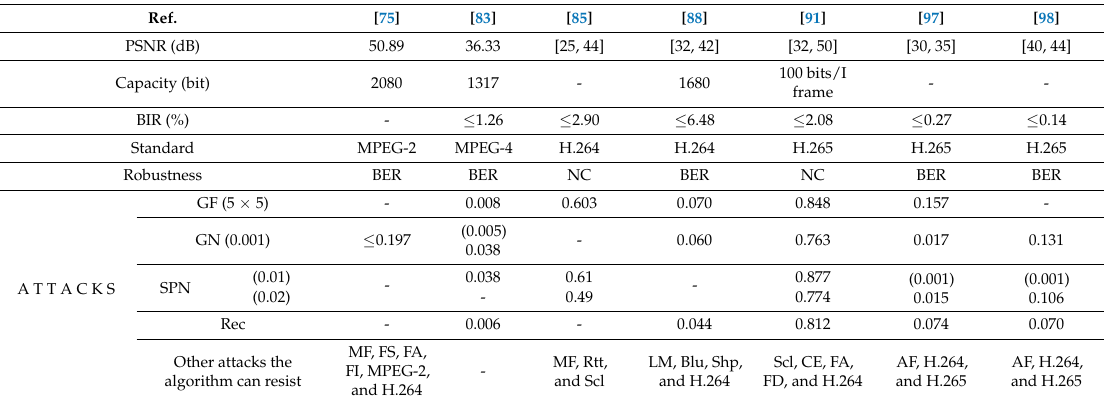
Table 12. Quantitative comparison of invisibility, capacity, BIR, and robustness of several typical algorithms in compressed domain.